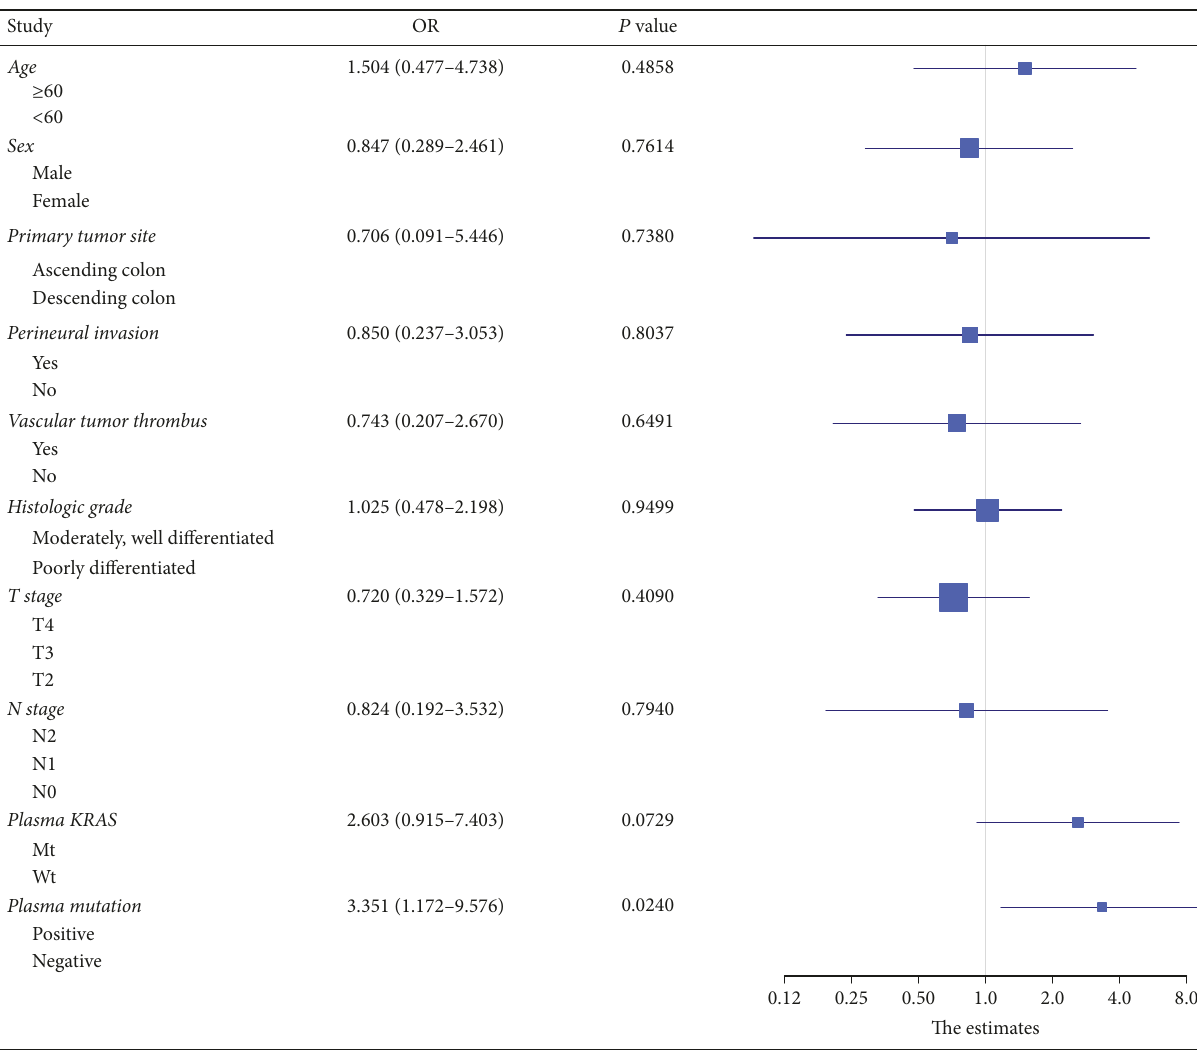
Figure 5: Forrest plot of hazard ratios for PFS of the subsequent first-line chemotherapy patients. Except for plasma RAS/BRAF mutations, other clinical factors including age, gender, primary tumor site, perineural invasion, vascular tumor thrombus, histologic grade, T stage, and N stage were not significantly associated with PFS.